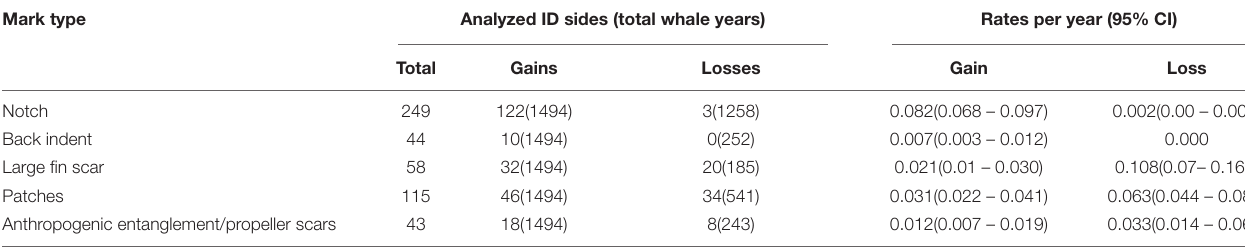
TABLE 5 | Annual rates of mark change found on the Scotian Shelf